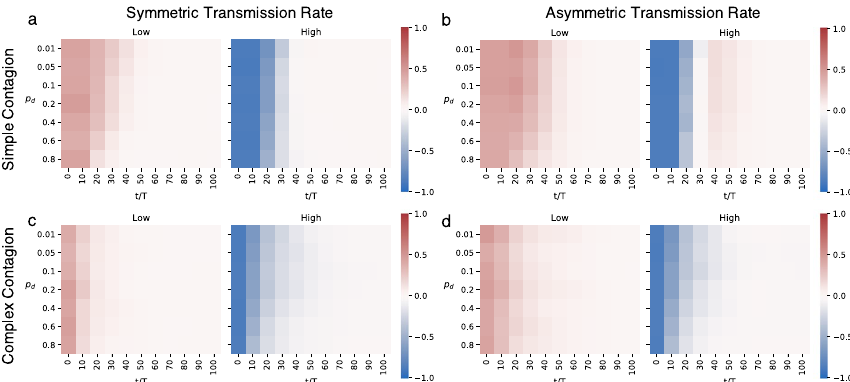
Fig. 6 Information spreading equality for diversified homophily BA with different diversification probabilities p d . In general, we observe that the higher the p d , the higher the information access equality, especially for low minority seeding